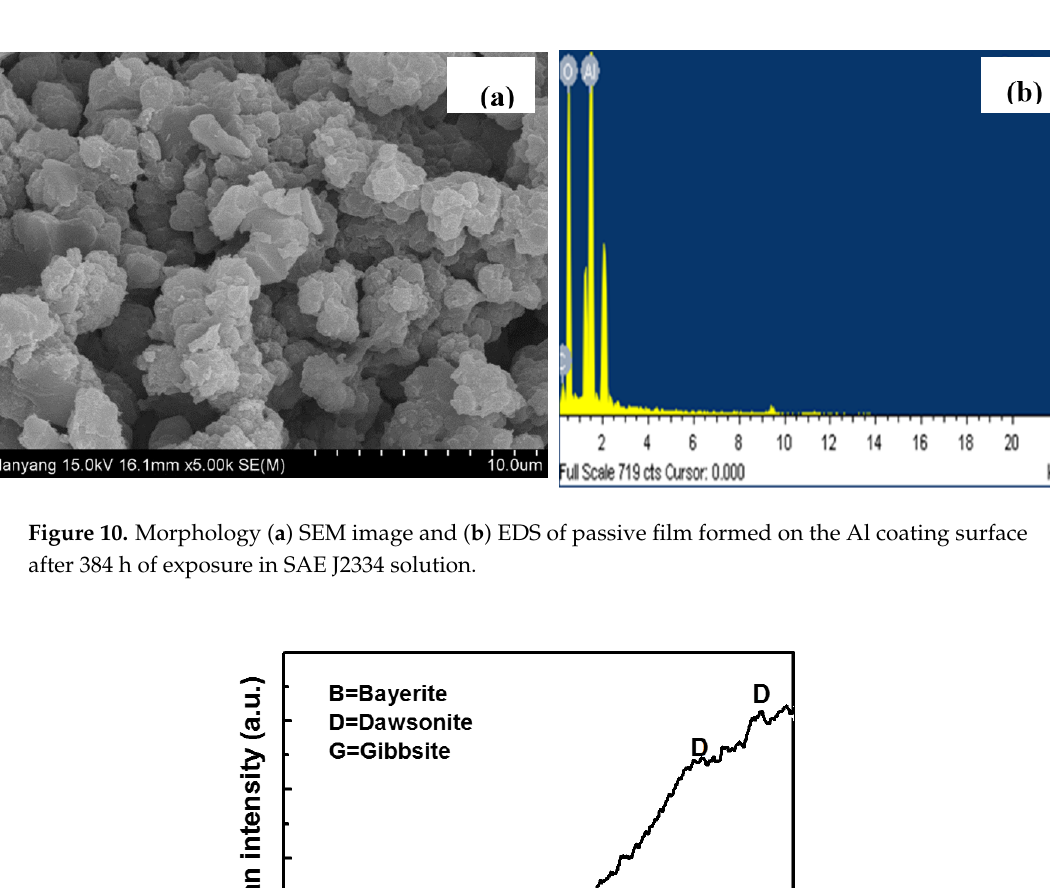
Figure 10. Morphology ( a ) SEM image and ( b ) EDS of passive film formed on the Al coating surface after 384 h of exposure in SAE J2334 solution.